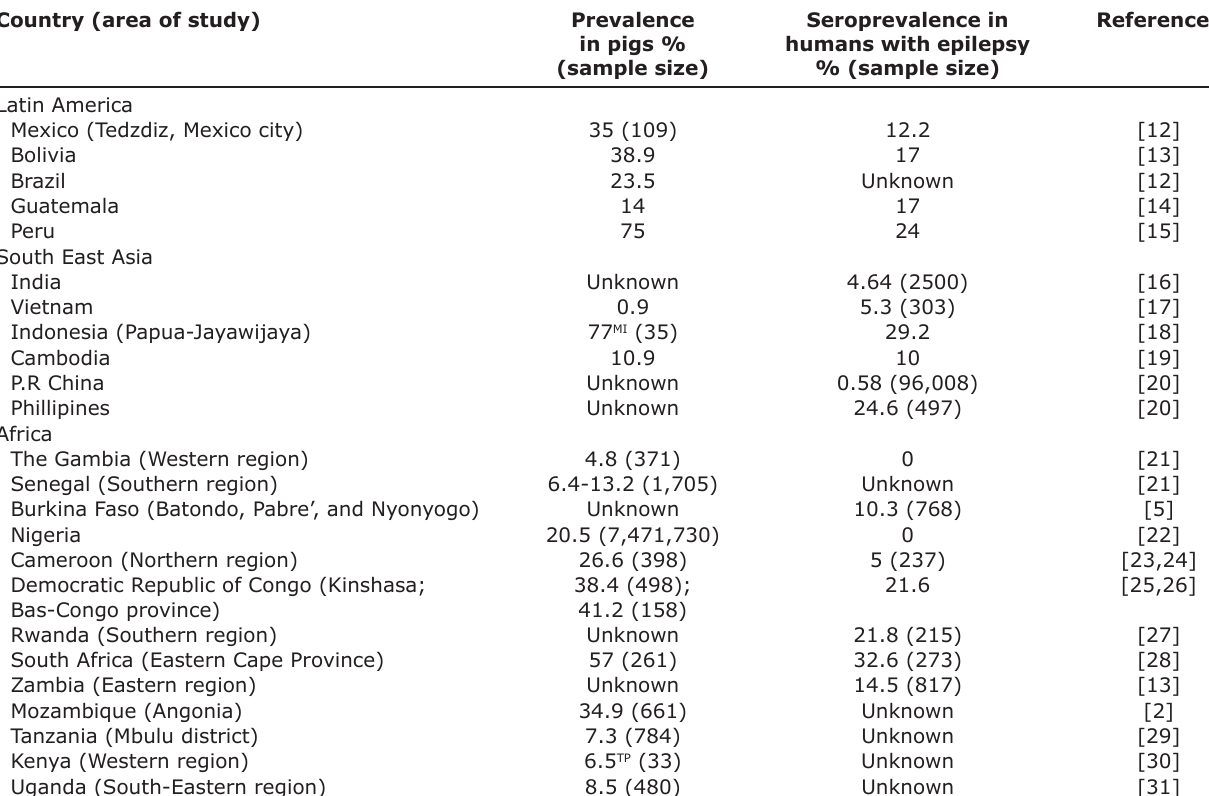
Table-1: Prevalence findings on T. solium cysticercosis of studies conducted from 2002 to 2013 in selected developing